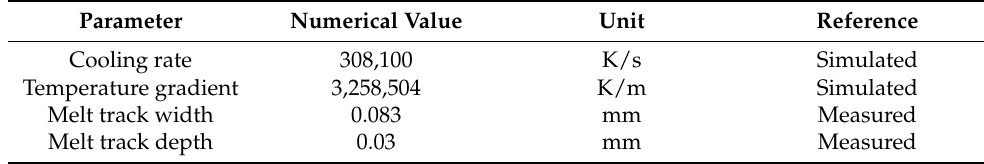
Table 4. Parameters used for microstructure simulation.